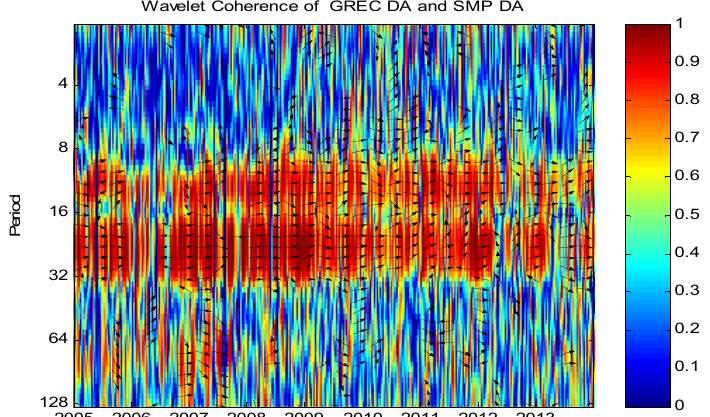
Figure 13. Wavelet coherence of hourly price GREC DA and SMP DA. The horizontal axis shows time, while the vertical axis shows the scale or period in hours. The warmer the colour of a region, the higher the degree of dependence or coherence between the two series.